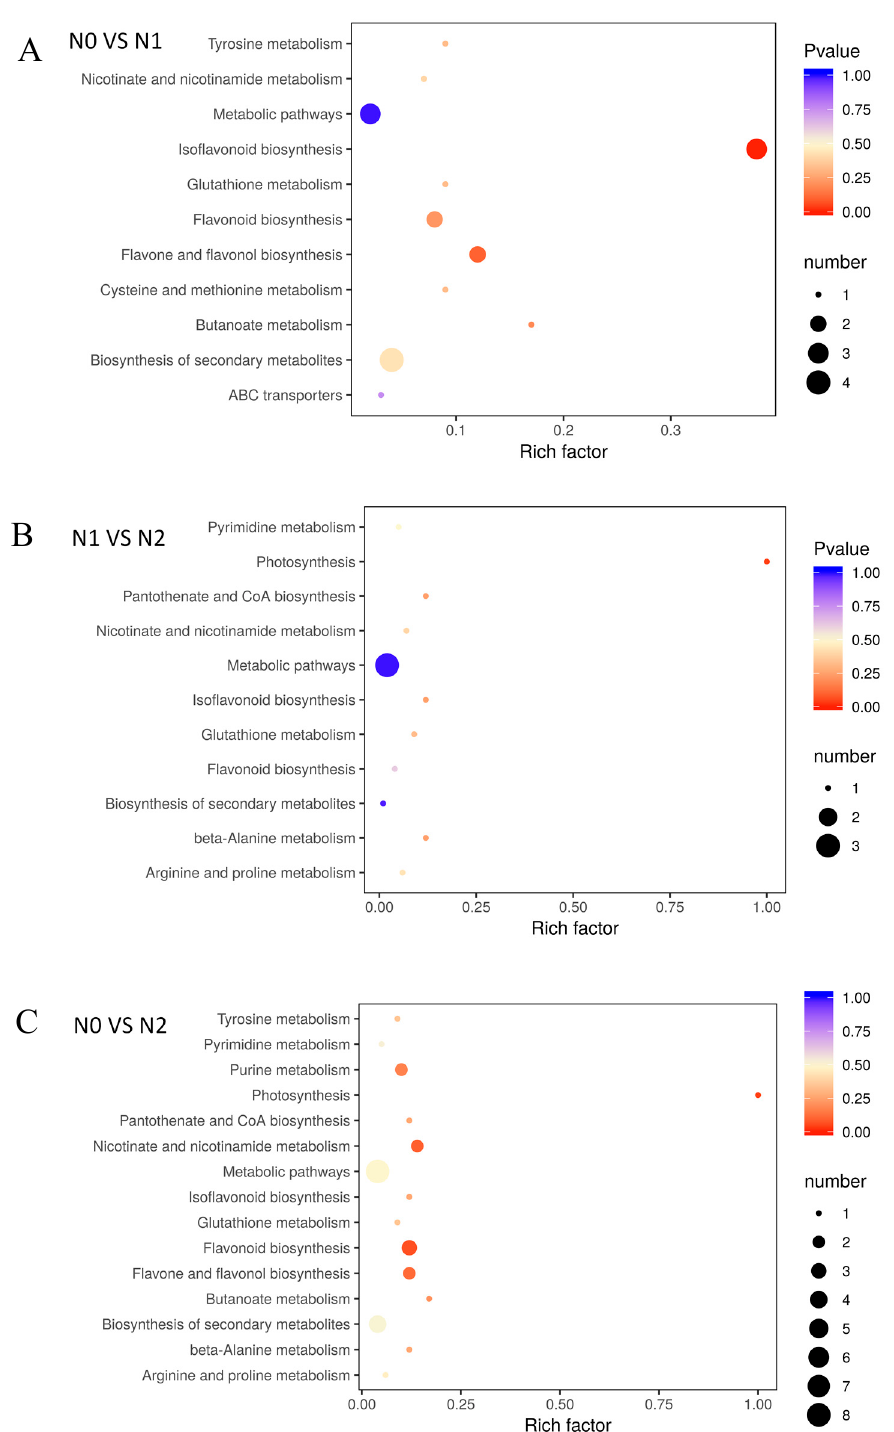
Figure 4. Enrichment analysis of KEGG. ( A ) N0 VS N1; ( B ) N1 VS N2; ( C ) N0 VS N2; The p -value represents the degree of enrichment, and the p -value is close to 0, indicating that the enrichment is more significant. The size of point represents the number of differential metabolites.